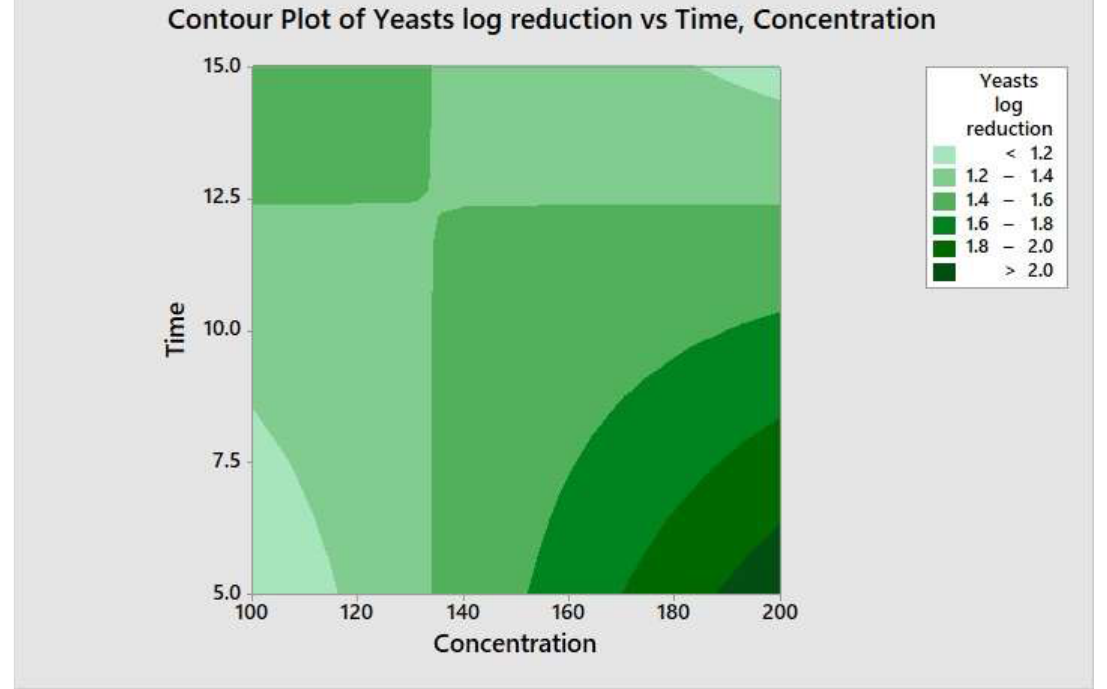
Figure 9. Contour plot of the yeasts logs reduction versus time and concentration.